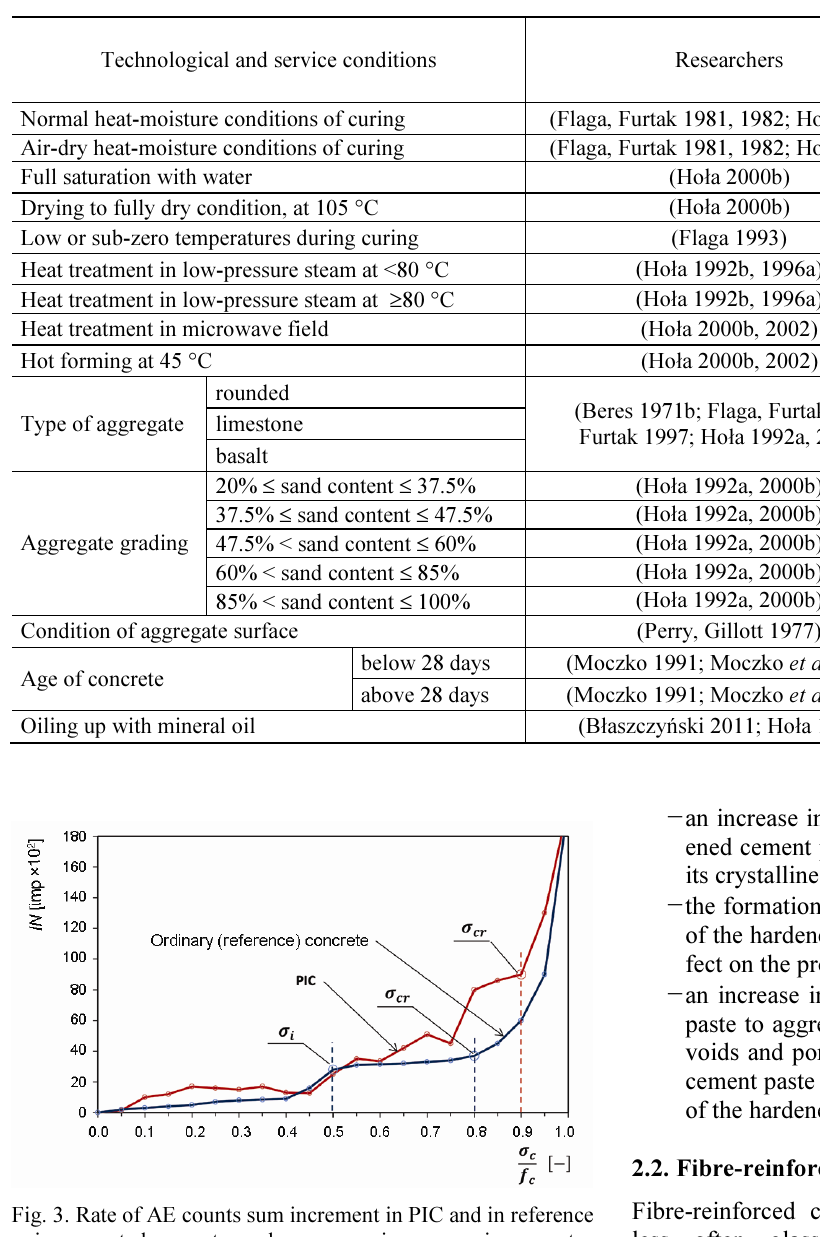
Table 1. Relative levels of cracking initiating stress σ i and critical stress σ cr for various technological and nonmechanical service factors acting on ordinary concrete under compression